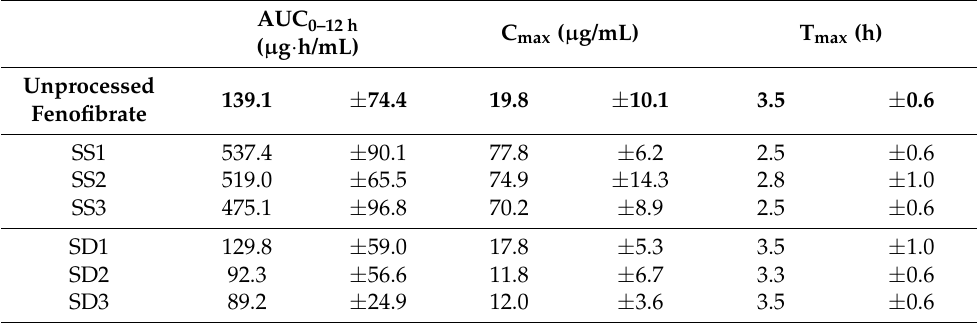
Figure 10. Serum concentration-time profiles of fenofibric acid after single dosing peroral adminis- tration of 50 mg/kg in rats. Six different formulations were tested: SS1, SS2, SS3, SD1, SD2, and SD3 (mean ± S.D., n = 4). Table 5. Pharmacokinetic parameters of unprocessed fenofibrate and the SA-SD-processed and the SD-processed fenofibrate-additive microparticles after oral administration in Sprague–Dawley rats (mean ± S.D.; n =